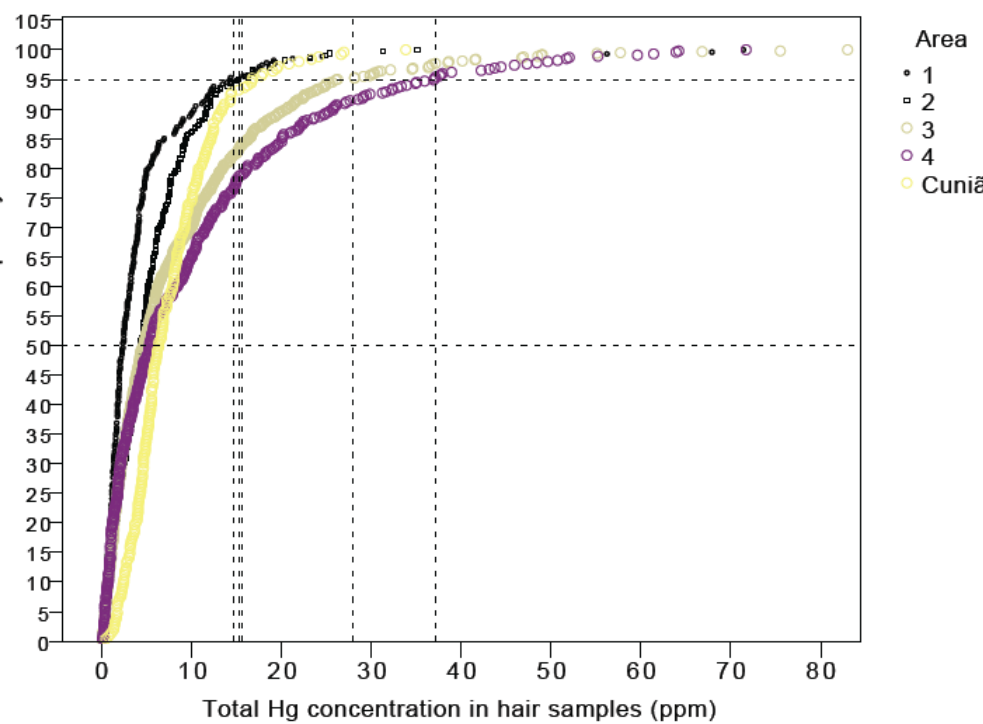
Figure 3. Percent distribution of hair-Hg concentrations illustrating the four village groups. Area 1 (downstream the rapids, right bank), Area 2 (downstream the rapids, left bank), Area 3 (upstream the rapids, right bank), Area 4 (upstream the rapids, left bank) and the extractive reserve of the Cuniã Lake (Area 5), about 180 km downstream the rapids. Porto Velho city is the capital of Rondônia